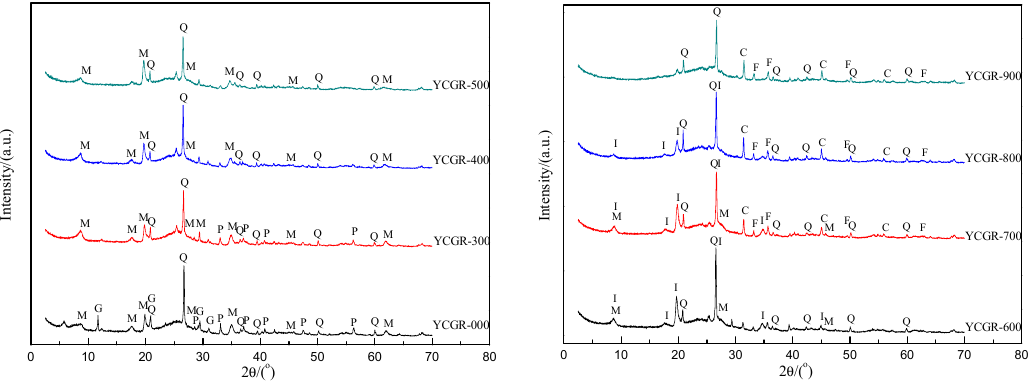
Figure 3. X-ray diffraction (XRD) patterns of raw coal and char samples obtained from pyrolysis at different temperatures at a fast heating rate. Q: quartz; P: pyrite; M: mica (muscovite, polylithionite, fluorphlogopite); G: gypsum; I: illite; C: oldhamite; F: hematite.